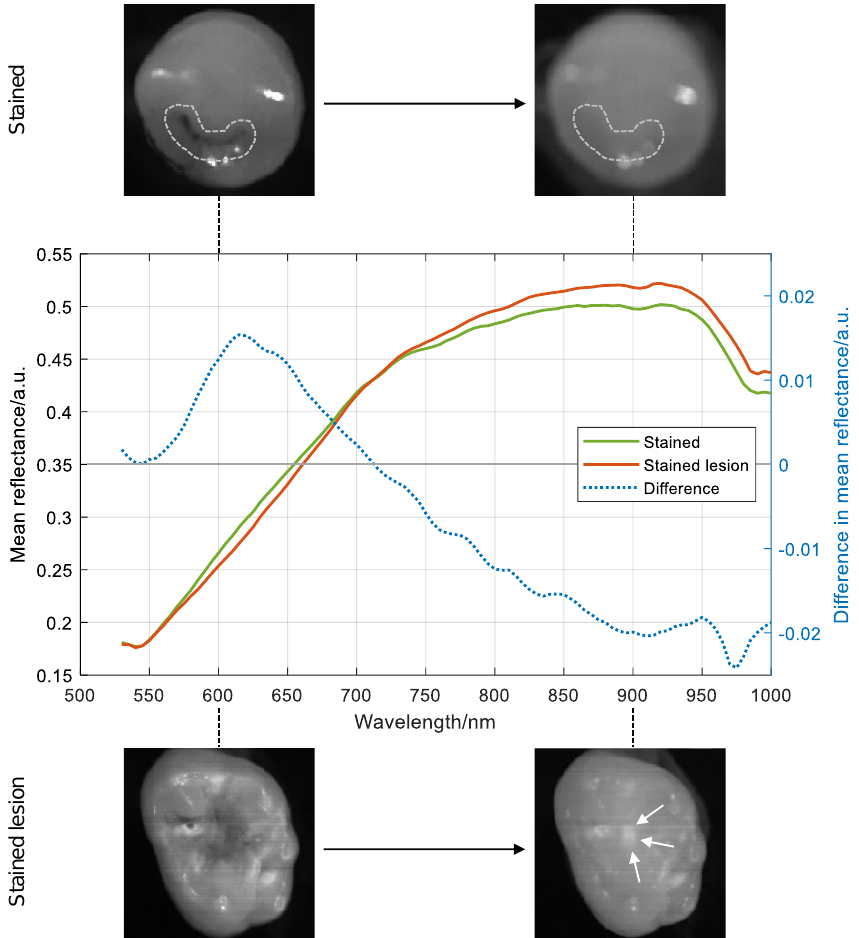
Figure 3. Mean reflectance spectra of stains and stained lesions, respectively, and their difference spectrum (dotted blue line, difference = reflectance stained − reflectance stained lesion ), together with sample reflectance images. The mean reflectance of stained lesions exceeds that of stained enamel for wavelengths above 710 nm, whereas it is lower or indifferent for wavelengths below 710 nm. The wavelength region 505–525 nm was eliminated due to high noise. The reflectance images show how stains visible at a wavelength of 600 nm are rendered transparent at a wavelength of 900 nm, and underlying demineralization (white arrows) becomes visible. a.u.: arbitrary